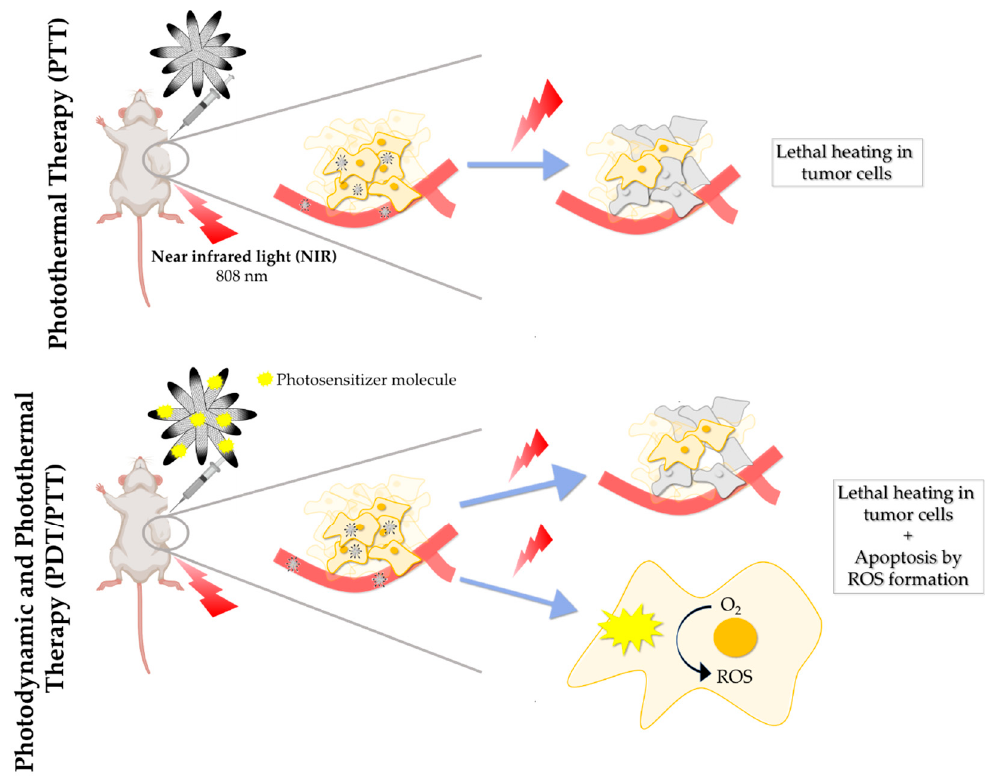
Figure 6. Schematic illustration of PTT and PDT / PTT combination in mice with subcutaneous tumor.